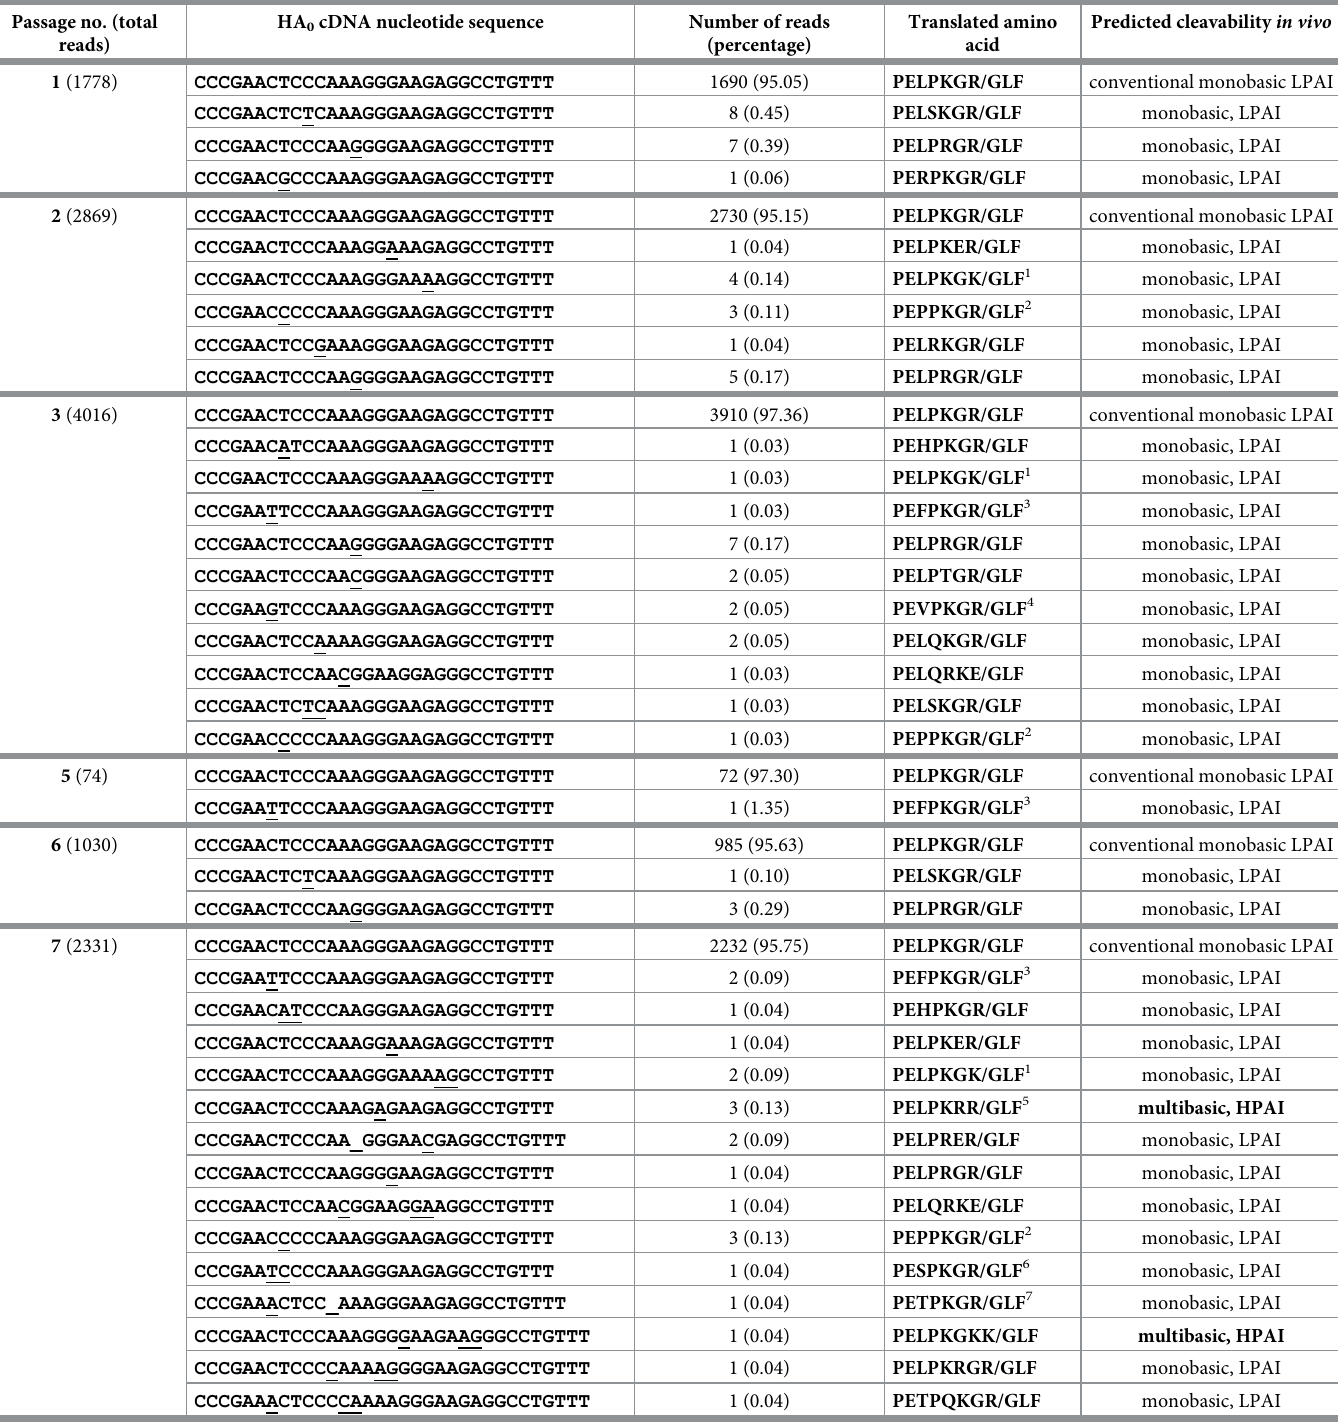
Table 5. Hemagglutinin cleavage sites (HA 0 ) detected in the H7N1 low pathogenic avian influenza virus passaged in 14-day old ECEs. Passage no. (total